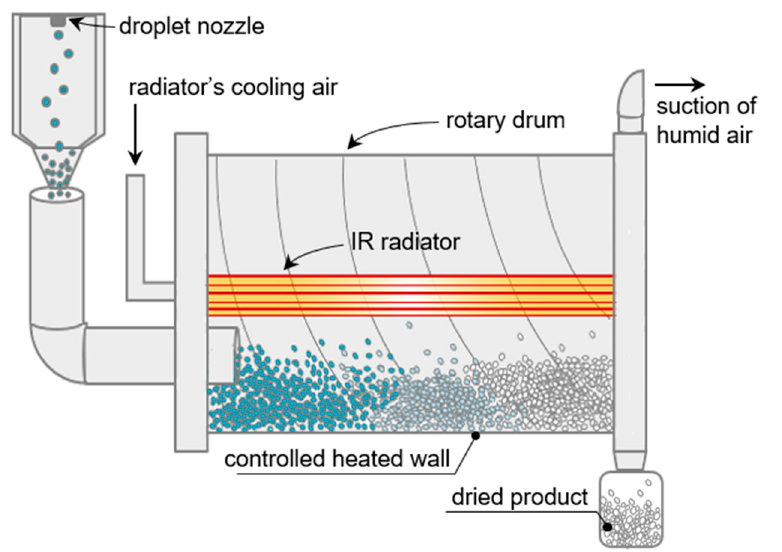
Figure 4. Scheme of the conceptual design of dynamic freeze-drying process with continuous removal of dried particle fraction.